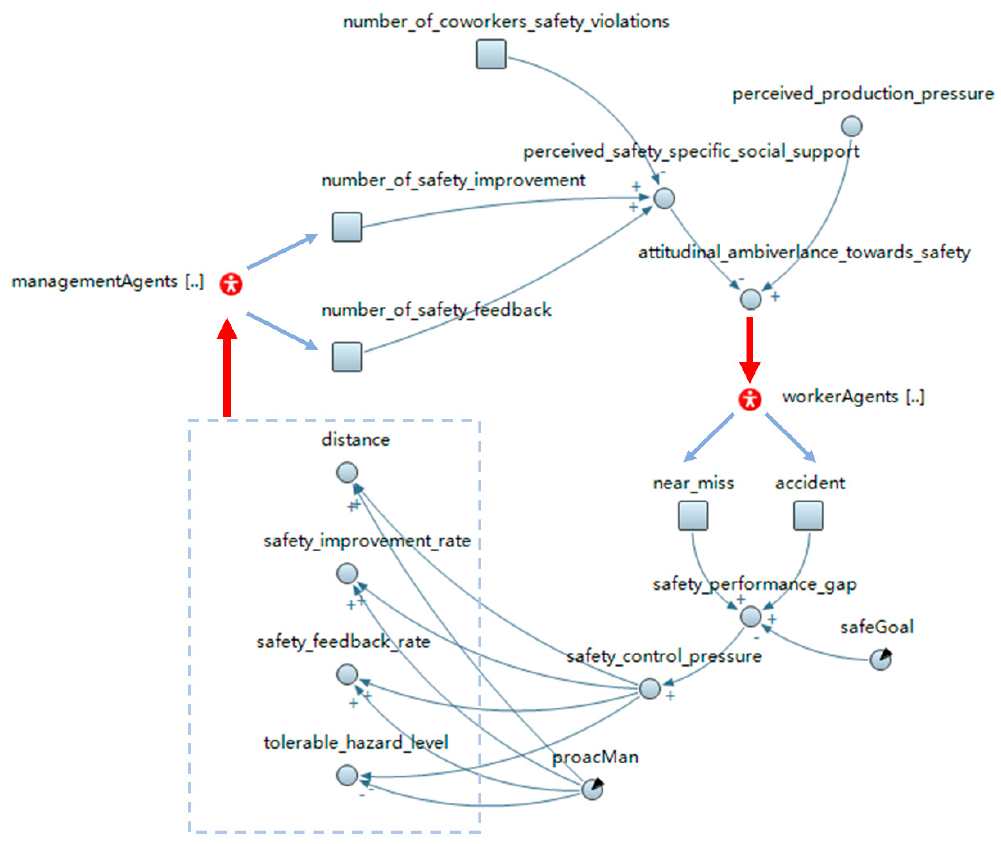
Figure 4. Feedback structure of the system level dynamics.